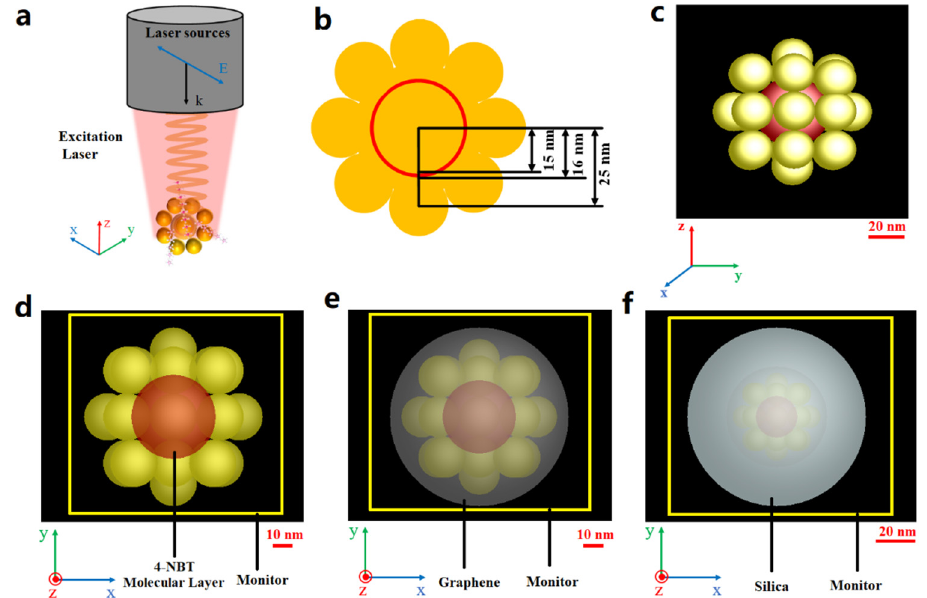
Figure 6. ( a ) Schematic diagram of the Raman tag electric field effects simulation model; ( b ) 2D dimension drawing of P-GERTs simulation model; ( c ) 3D simulation model of P-GERTs, the scale bar is 20 nm; ( d – f ) Monitor setup planes for P-GERTs, GP-GERTs, and MS-GP-GERTs, the scale bars are 10 nm, 10 nm and 20 nm, respectively.